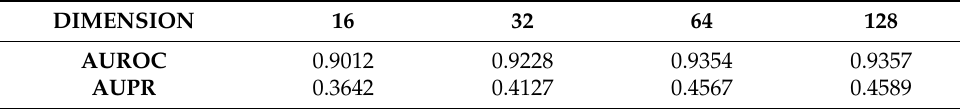
Table 5. AUROC and AUPR at a different dimension of hidden